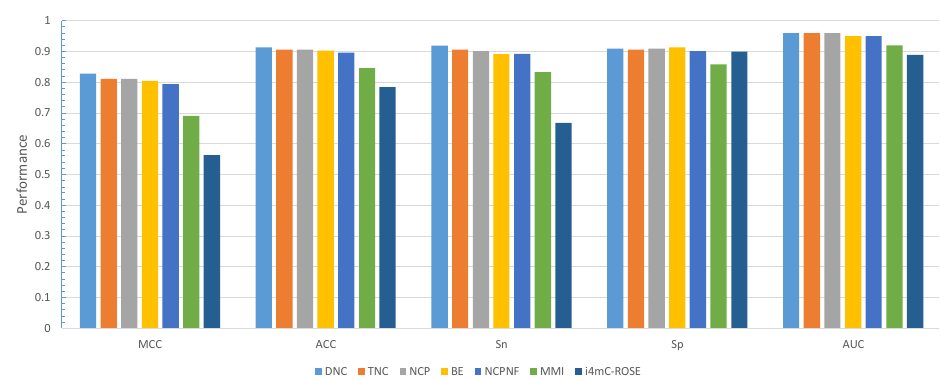
Figure 3. Grapical demonstration of performance comparison between six encoding methods and state-of-the-art model on training Rosa Chinensis dateset.